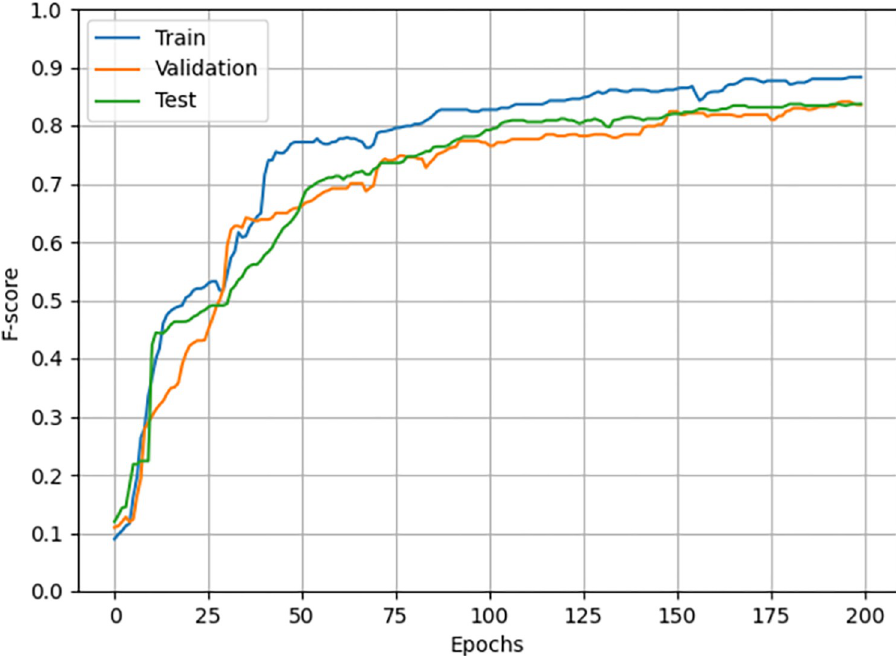
Fig 1. F1-score fluctuations of the MLP model per